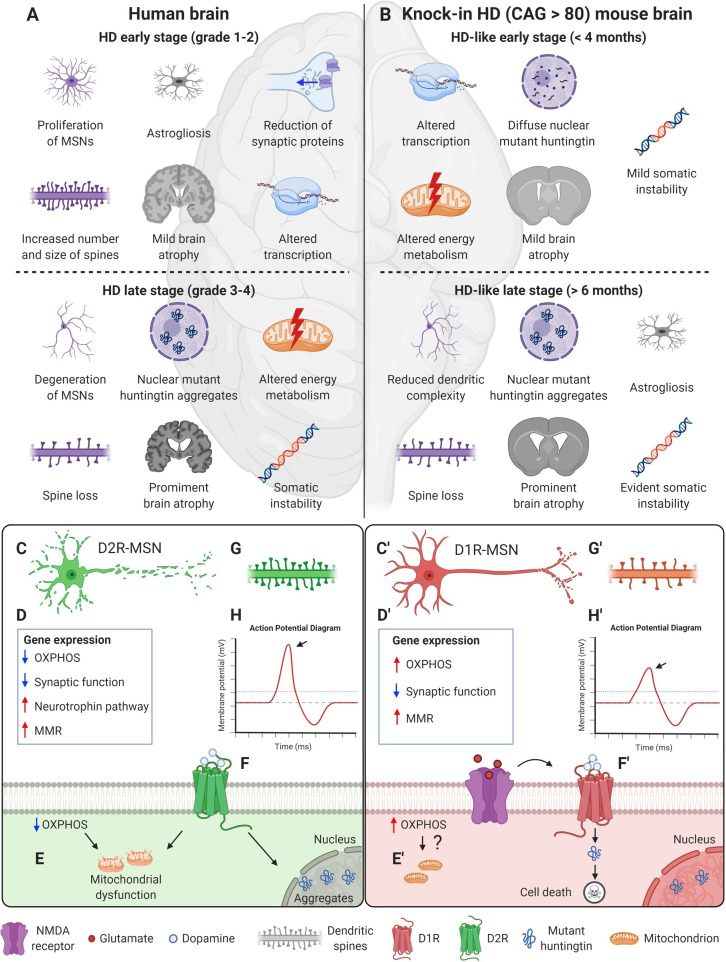
HD profoundly alters the striatum and MSNs in both patients and mouse models, upper panel. (A) Schematic representation of HD patient brain. At the early stage of the disease (grade 1–2), patients already manifest mild brain atrophy and astrogliosis (Ross and Tabrizi, 2011; Rüb et al., 2016). MSNs undergo proliferative expansion and show increased number and size of spines (Ferrante et al., 1991). At the molecular level, a reduction of synaptic proteins and alterations in gene transcription are detected (DiProspero et al., 2004; Hodges et al., 2006). These changes continue during advanced stages (grade 3–4), when brain atrophy becomes prominent (Rüb et al., 2016). MSNs undergo degenerative changes and spine loss, and mutant huntingtin aggregates can be detected within nuclei (Ferrante et al., 1991; DiFiglia et al., 1997; Rüb et al., 2016). Altered energy metabolism and somatic instability of the CAG tract are detected (Gines et al., 2003; Swami et al., 2009; Liot et al., 2017). (B) Knock-in HD mouse models (CAG > 80) faithfully recapitulate the human HD mutation and mimic several aspects of the human condition. At early age (<4 months), mice show mild brain atrophy (Peng et al., 2016) and diffuse accumulation of mutant huntingtin within MSNs nuclei (Carty et al., 2015). At the molecular level, energy metabolism and transcription are altered (Gines et al., 2003; Mochel et al., 2012; Ament et al., 2017). Somatic instability is already detectable at this stage (Pinto et al., 2013). At later stages (>6 months), brain atrophy becomes more prominent and astrogliosis could be detected (Menalled, 2005; Lerner et al., 2012; Peng et al., 2016). MSNs show reduced dendritic complexity and spine loss, and nuclear mutant huntingtin aggregates inclusions (Lerner et al., 2012; Carty et al., 2015). The molecular alterations proceed and somatic instability becomes particularly evident (Lee J.M. et al., 2011). Specific pathways and phenotypes developed by D1R- and D2R-MSNs upon expression of mutant huntingtin, lower panel. (C,C′) Striatopallidal neurons (D2R-MSNs) are affected earlier than striatonigral ones (D1R-MSNs) by HD mutation (Sapp et al., 1995). (D,D′) Gene expression profiling on R6/2 mice revealed that neurotrophin pathway is specifically upregulated in D2R-MSNs, while mismatch repair (MMR) and synaptic functioning pathways seem to be altered in both MSNs subpopulations (Lee et al., 2020). (E) In both R6/2 and zQ175 mice, oxidative phosphorylation (OXPHOS) downregulation observed in D2R cells contribute to mitochondrial dysfunction (Lee et al., 2020), while (E′) OXPHOS genes are upregulated in D1R cells, possibly suggesting a homeostatic response (Lee et al., 2020). (F) In mice and rat striatal cell cultures overexpressing mutant huntingtin, D2R stimulation enhances mutant huntingtin aggregation and mitochondrial dysfunction (Charvin et al., 2005; Benchoua et al., 2008). (F′) In HdhQ111 models, dopamine and glutamate synergistically enhance MSNs sensitivity to mutant huntingtin toxicity through D1R activation (Paoletti et al., 2008). (G,G′) In 12 months old zQ175 KI mice, D1R neurons show proliferative expansion of the dendritic arborization and a significant reduction in the density of thin spines, while D2R neurons do not show significant differences (Goodliffe et al., 2018). (H,H′) In the same model, only D1R neurons exhibit reduced rheobase and action potential amplitude (arrows). Figure created with BioRender.com.